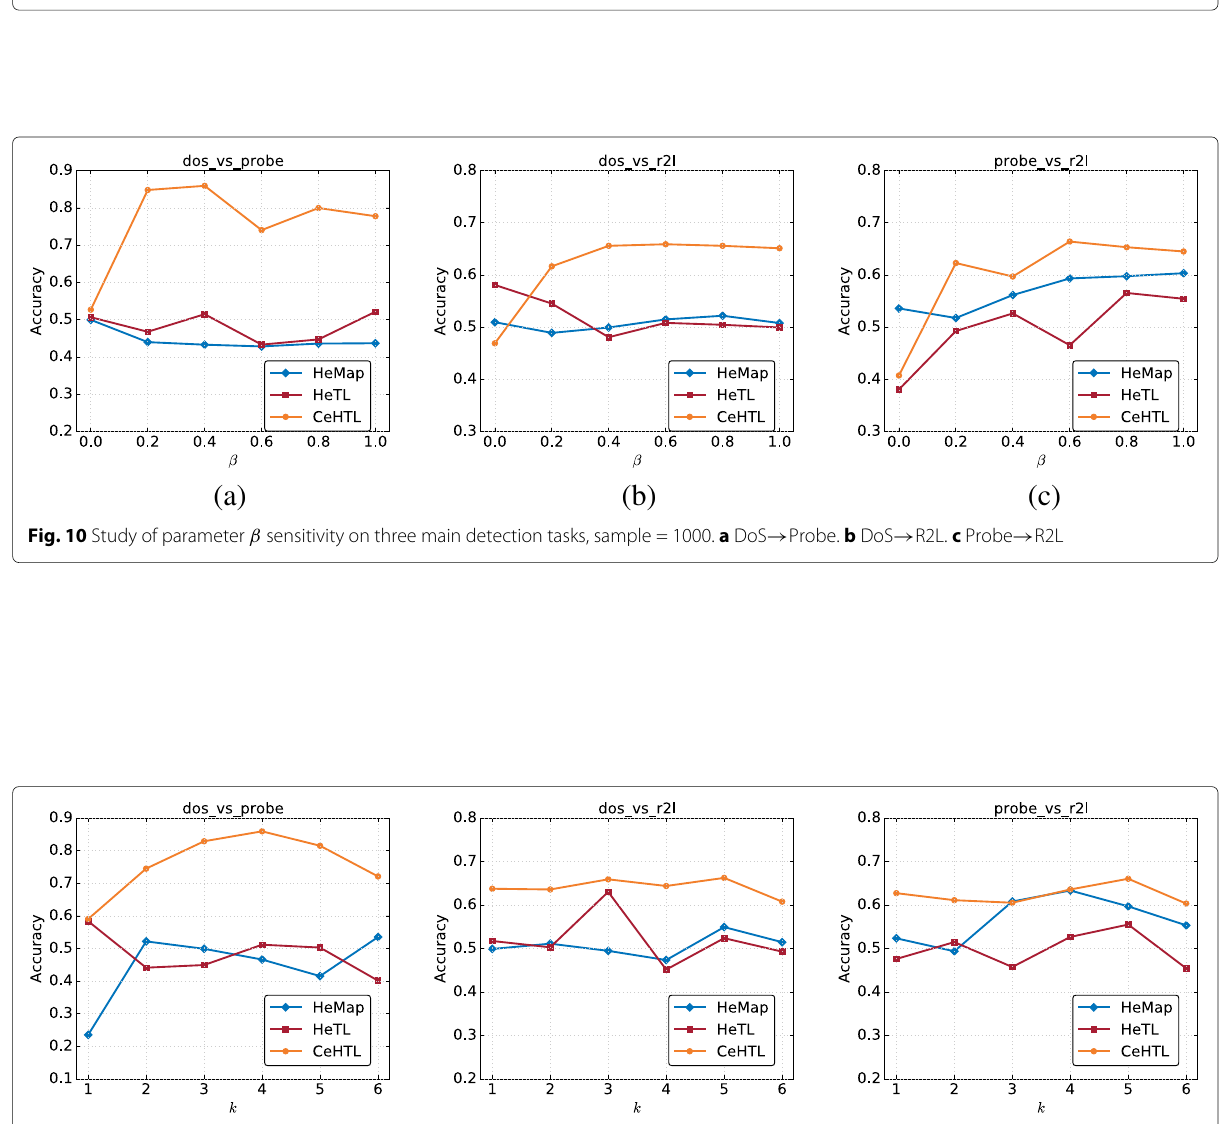
Fig. 9 Accuracy comparison with different combinations of k and β , sample = 1000. a DoS → Probe. b DoS → R2L. c Probe → R2L